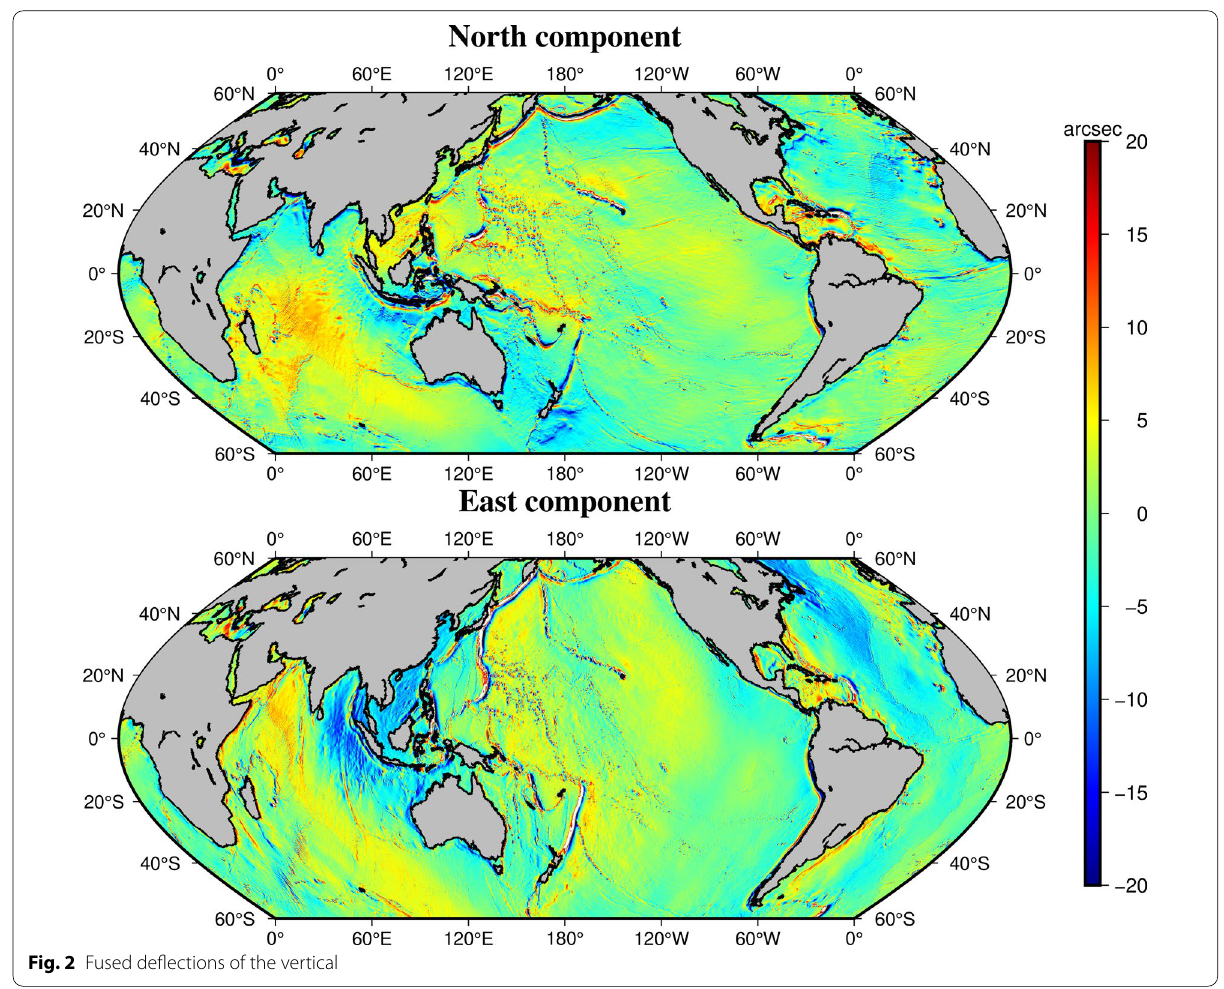
Fig. 2 Fused deflections of the vertical